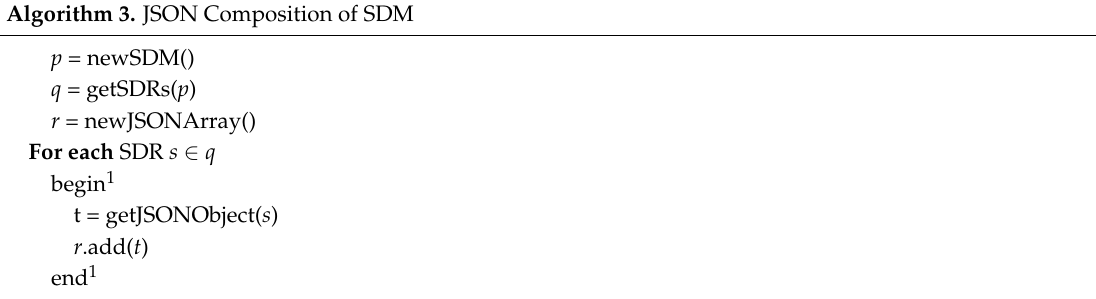
Algorithm 3. JSON Composition of